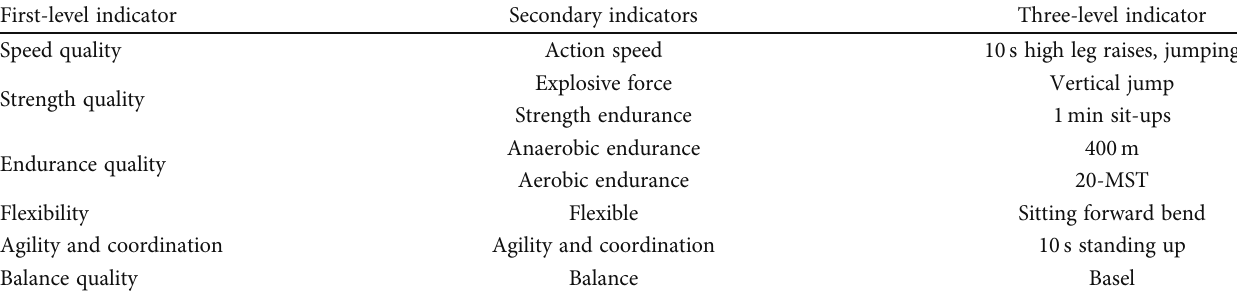
Figure 4: Schematic diagram of the structure of the motion monitoring system. Table 2: Physical fi tness test indicators of sports